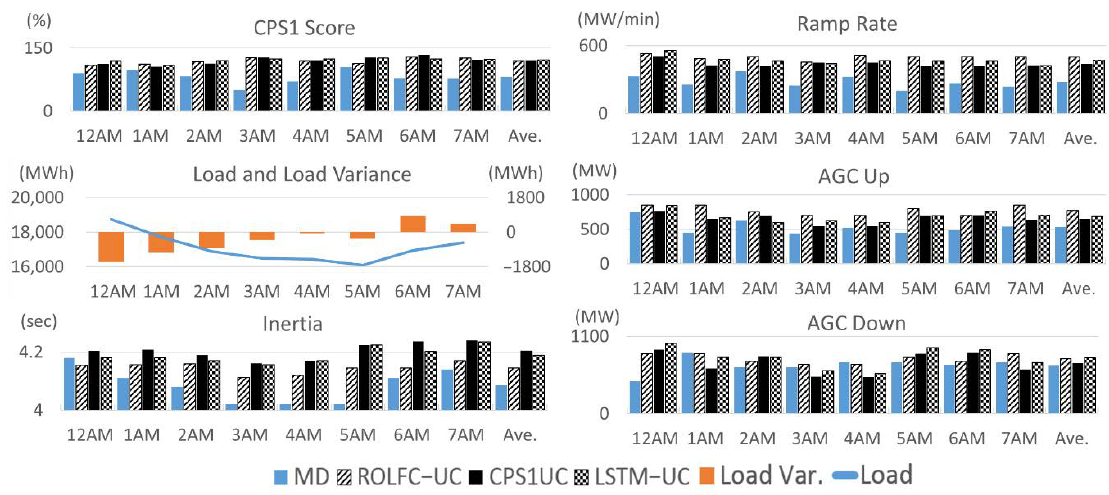
Figure 9. Hourly results of each scenario in the Normal Operation